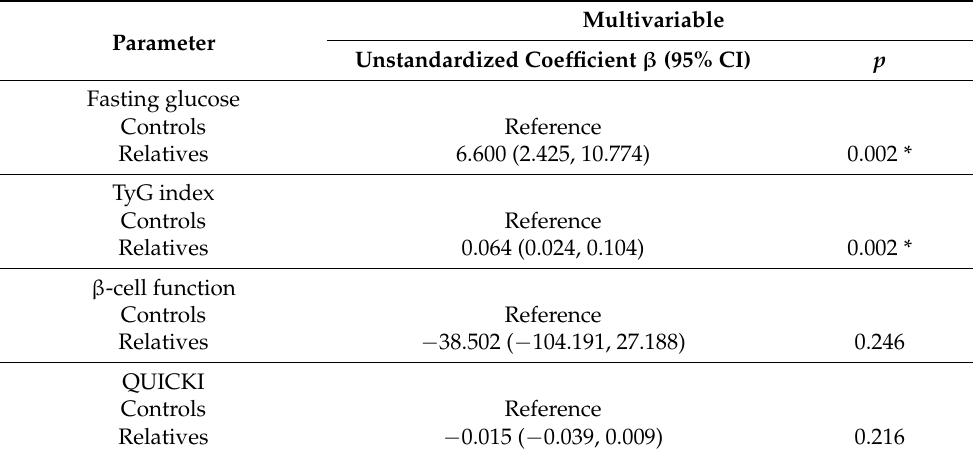
Table 7. Determinants of various parameters using multivariable linear regression analysis in control vs. relatives by age, sex and BMI match.